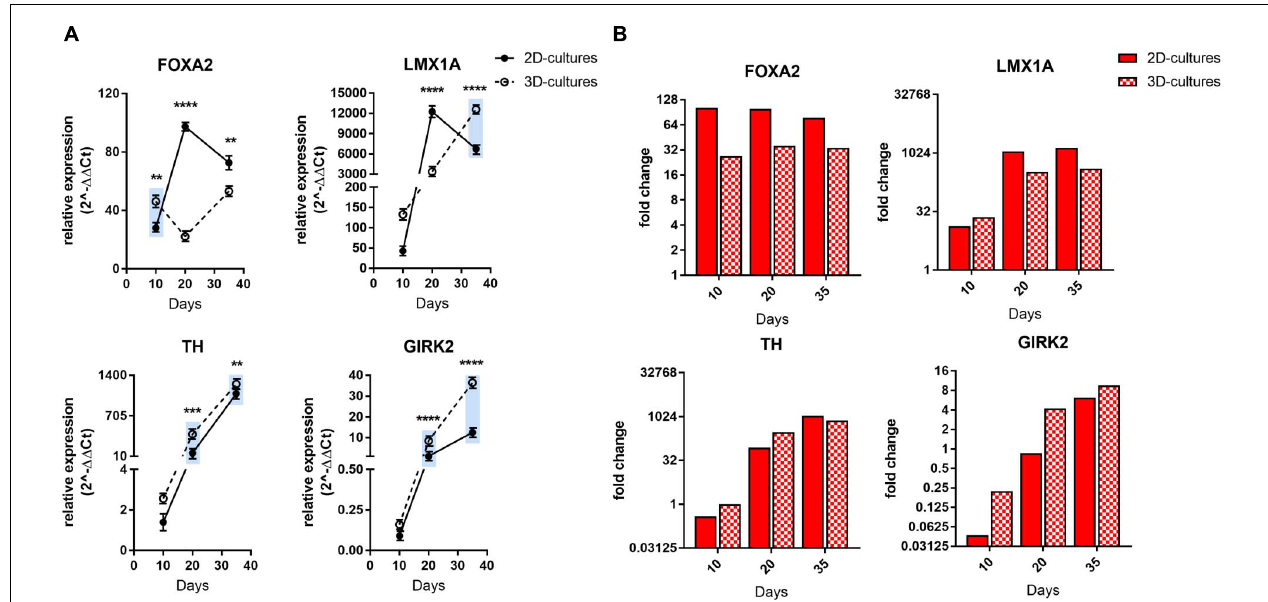
FIGURE 2 | Comparative gene expression analyses of mDA progenitor induction as well as maturation into post-mitotic mDA neurons. (A) qRT-PCR analysis of FOXA2, LMX1A, TH, and GIRK2 at days 10, 20, and 35 of differentiation. The blue bars are illustrating an ameliorated phenotype of 3D cultures compared to the 2D counterpart. Statistical differences were calculated by multiple unpaired t -tests ** p ≤ 0.01, *** p ≤ 0.001, **** p ≤ 0.0001. (B) Bars represent expression fold change of FOXA2, LMX1A, TH and GIRK2 genes at each time point (day 10, 20, 35) with respect to differentiation start (hiPSCs) in the RNA-sequencing experiment. Values below 1 indicate down-regulation of expression. Red bars display gene expression change in 2D culture, whereas bars with red and white checker pattern visualize those from 3D culture. A single fold change value is derived from three replicates for each comparison presented